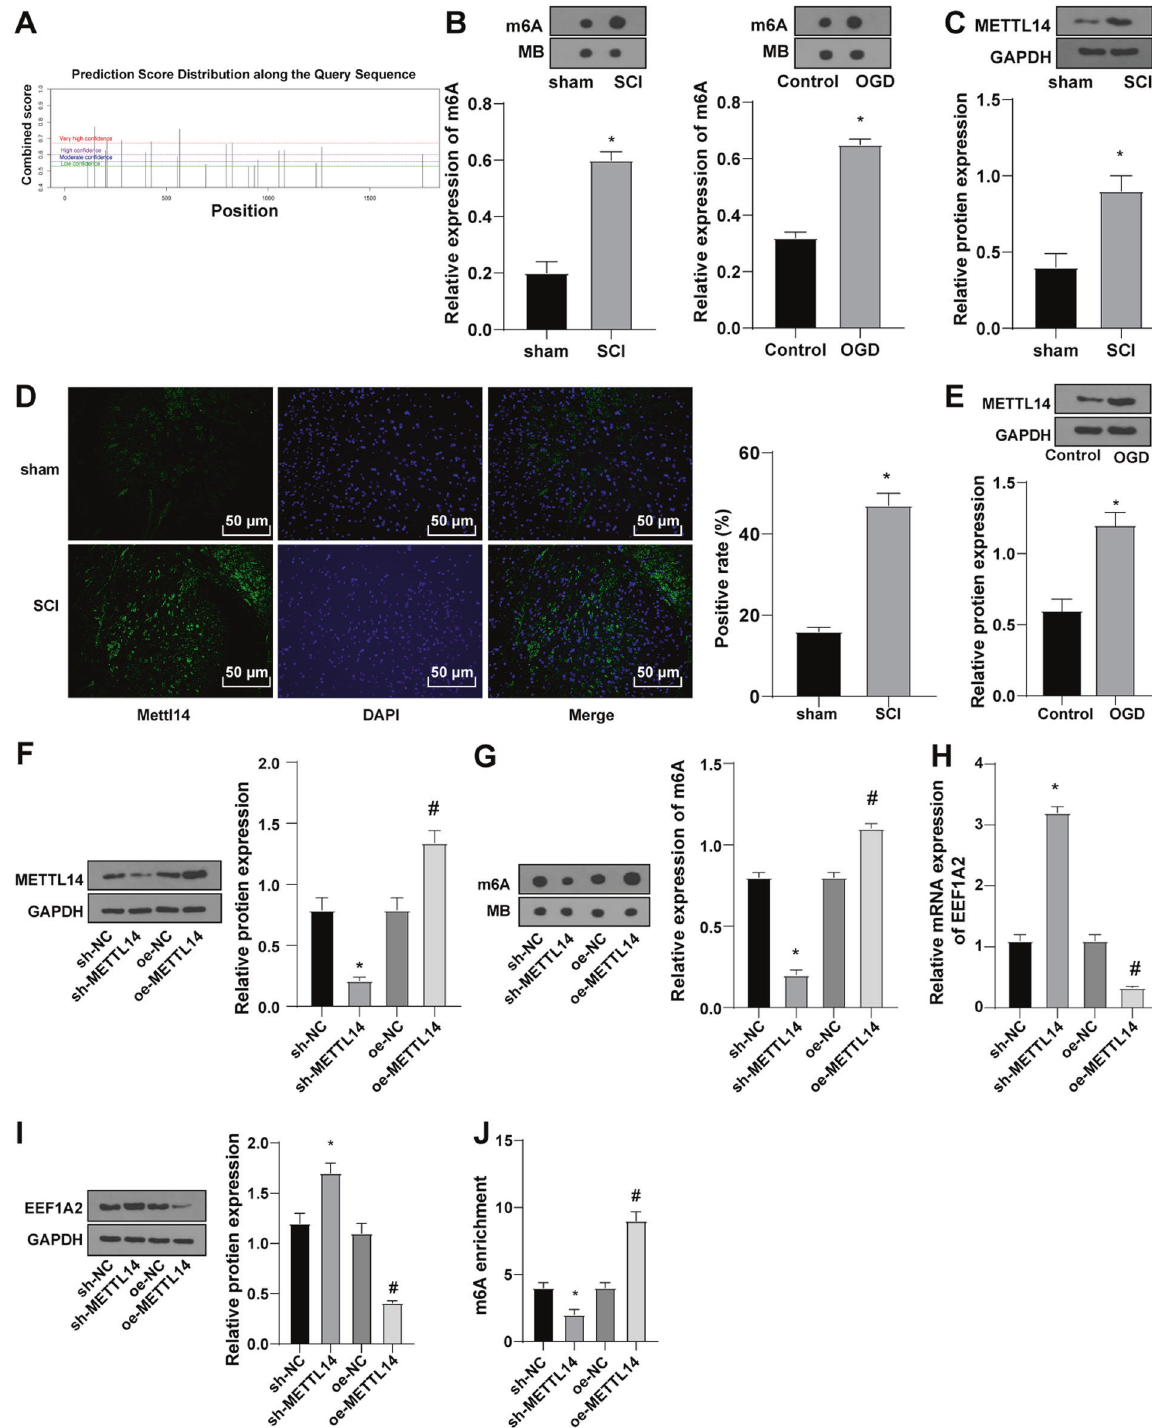
Fig. 4 Mettl14 downregulated EEF1A2 in SCI by mediating m6A methylation of EEF1A2. A possible m6A methylation sites of EEF1A2; ( B ) m6A level in spinal cord tissues and H/R neurons detected by Dot blot assay; ( C ) expression of Mettl14 in rat spinal cord tissues detected by Western blot ( N = 5); ( D ) expression of Mettl14 in spinal cord tissues detected by immuno fl uorescent staining ( N = 5); ( E ) expression of Mettl14 in H/R neurons detected by Western blot; ( F ): expression of Mettl14 detected by Western blot; ( G ) total m6A level detected by Dot blot assay; ( H ) mRNA expression of EEF1A2 detected by RT-qPCR; ( I ) EEF1A2 protein expression detected by Western blot; ( J ) m6A modi fi cation level of EEF1A2 detected by Me-RIP assay. Data were expressed as mean ± SD and analyzed using independent t test. The experiment was repeated three times. * vs sham group, control group, sh-NC group, p < 0.05; # vs oe-NC group, p < 0.05.